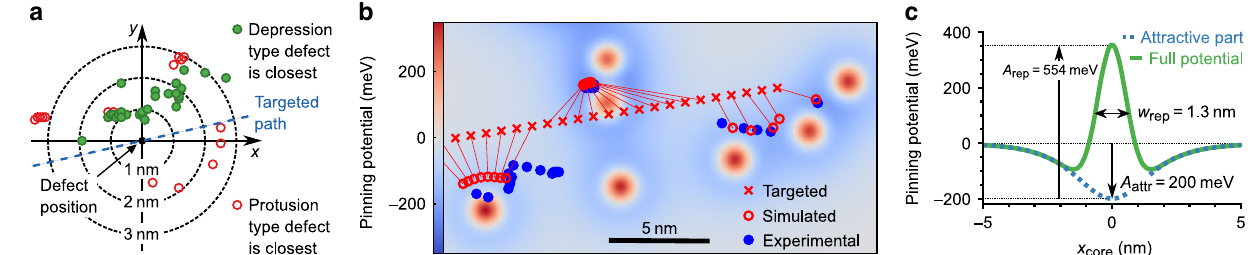
Fig. 4 Extracting the defect interaction potential. a Vortex core positions (symbols) with respect to the position of the closest adsorbate, differently colored for the two types of adsorbates. Targeted path (dashed line) reveals that pinning is mostly offset perpendicular to the target path. b Simulation of the vortex core path (red circles) within the displayed interaction potential (color map) that superposes the same pinning potential as displayed in c centered at each adsorbate. Adsorbate positions are taken from topography (Fig. 1f, white box). Experimental core positions (blue points, Fig. 1f) and target core positions (red crosses) are added. c The optimized, axially symmetric single defect potential consisting of an attractive part due to absent exchange energy (Fig. 3g) and a repelling Gaussian part. The three relevant fi t parameters are marked.